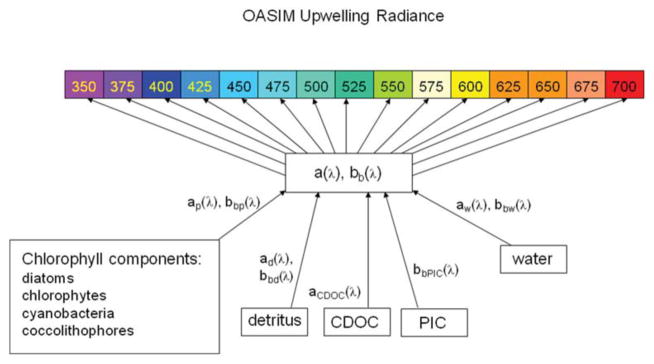
OASIM spectral upwelling radiance and dependencies in the oceanShown are the visible bands. The spectral resolution for upwelling radiance is 1 nm. Inherent optical properties are derived from spectral characteristics of water, phytoplankton groups, detritus. PIC, and CDOC.